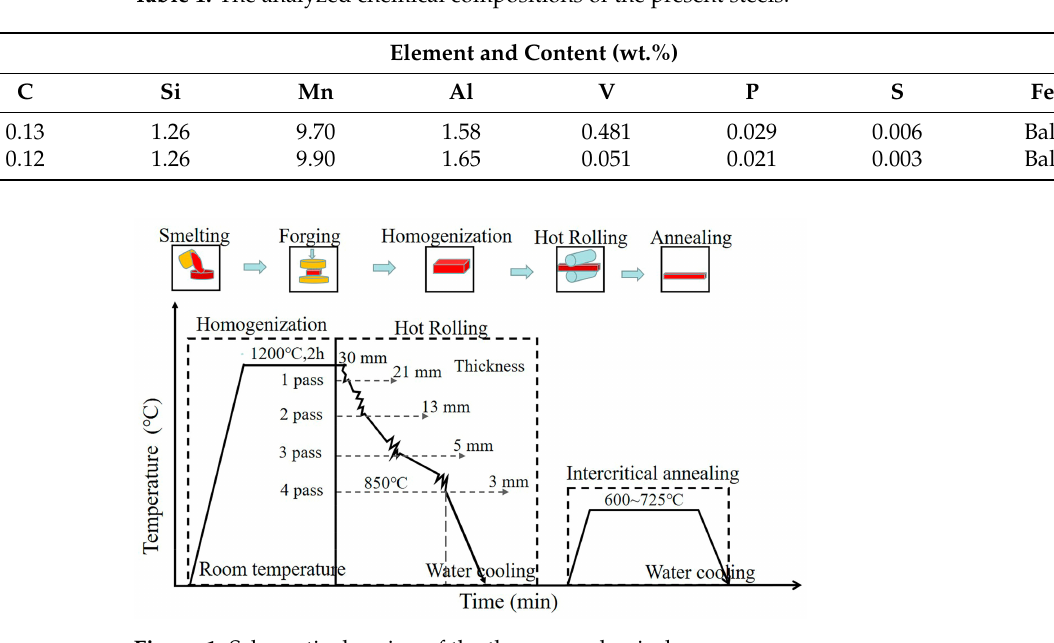
Figure 1. Schematic drawing of the thermomechanical